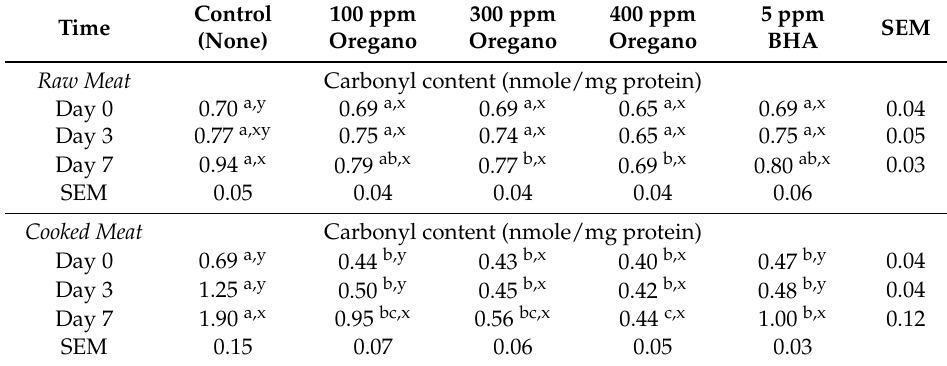
Table 2. Protein oxidation of raw and cooked chicken breast meat with different levels of oregano oil during storage.